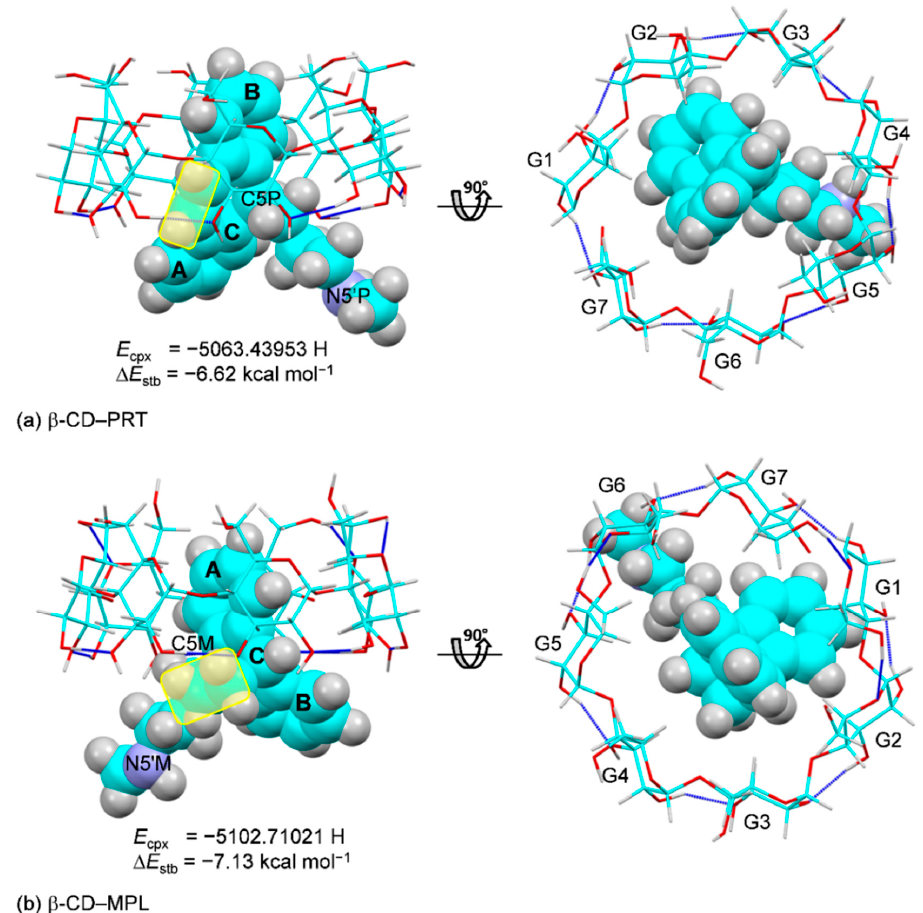
Figure 8. Inclusion complexes of ( a ) β -CD − PRT and ( b ) β -CD − MPL, derived from DFT complete-geometry optimization in the gas phase; side view ( left ) and top view ( right ). For comparison, the complex and stabilization energies ( E cpx and ∆ E stb ) are given; see also Table 3 and Tables S6 and S7. The belt of O3( n ) β -CD conformation are indicated by blue connecting lines. The PRT -CH=CH- bridge and the MPL -CH the central C-ring are emphasized in yellow areas.